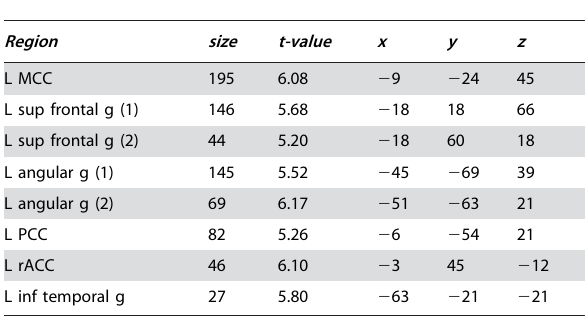
Cluster sizes are in voxels, t-values refer to the peak voxel in the cluster, and stereotactic coordinates are in MNI space (mm). Abbreviations: L=Left, MCC=middle cingulate cortex, PCC=posterior cingulate cortex, rACC=rostral anterior cingulate cortex, g=gyrus, s=sulcus, sup=superior, inf=inferior. The indices (1) and (2) are used to distinguish different clusters in similar anatomical